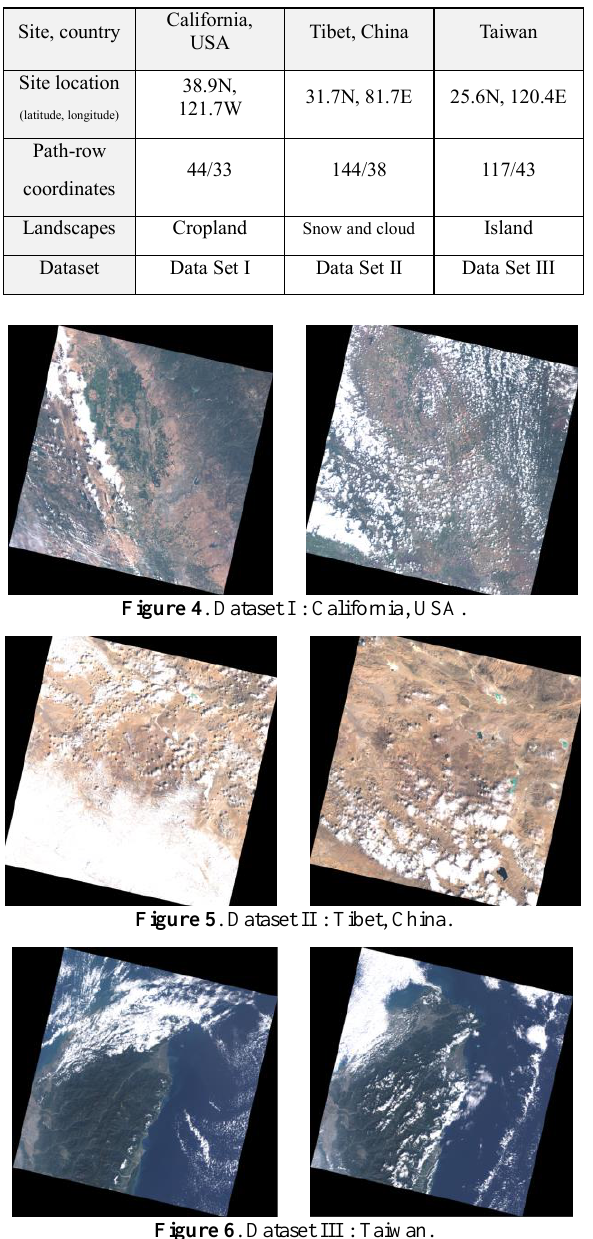
Figure 3 . Co-occurrence matrix results correspond to the two largest eigenvalues.